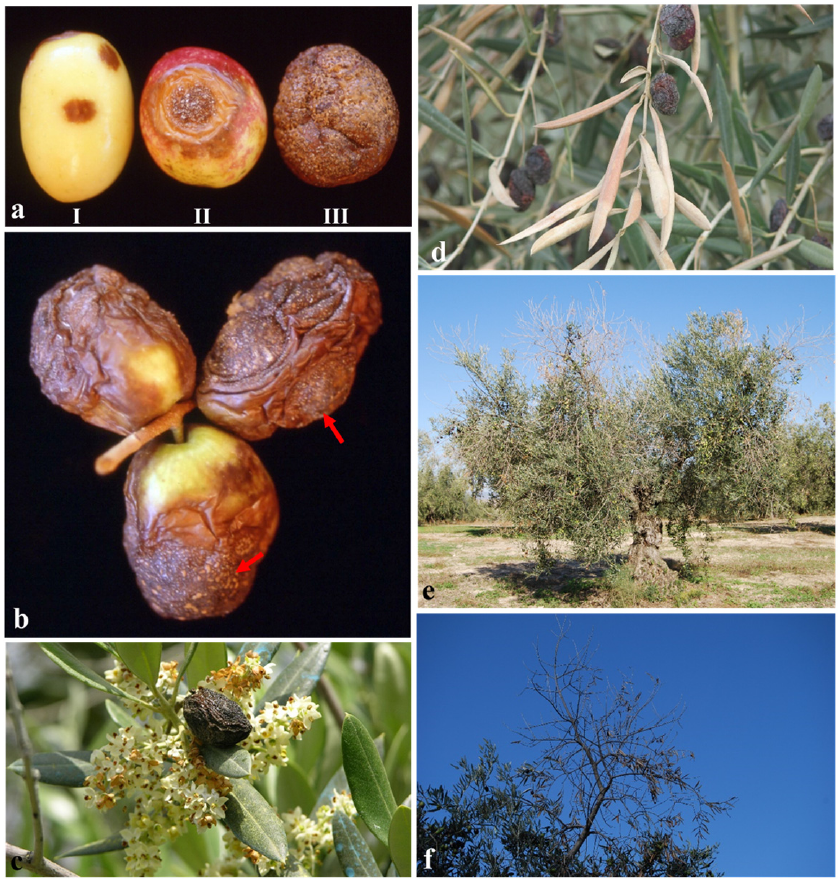
Figure 1. Typical symptoms of olive anthracnose. ( a ) Disease progression on naturally infected olive fruit (I: incipient symptoms; II: depressed, round, and ochre-brown lesions; III: rotted fruit with orange conidial masses produced by Colletotrichum spp.); ( b ) detail of orange conidial masses (red arrows) on infected olive fruit; ( c , d ) mummified fruit remaining in the tree canopy causing flower and leaf blight; ( e , f ) dieback of shoots and branches caused by Colletotrichum spp. in olive trees. The causal agent of olive anthracnose was described for the first time in Portugal by de Almeida [15] as Gloeosporium olivarum . Subsequently, this species was reclassified as Colletotrichum gloeosporioides (anamorph of Glomerella cingulata ) after reviewing the Gloeosporium genus by von Arx [16]. Later, the species C. gloeosporioides was